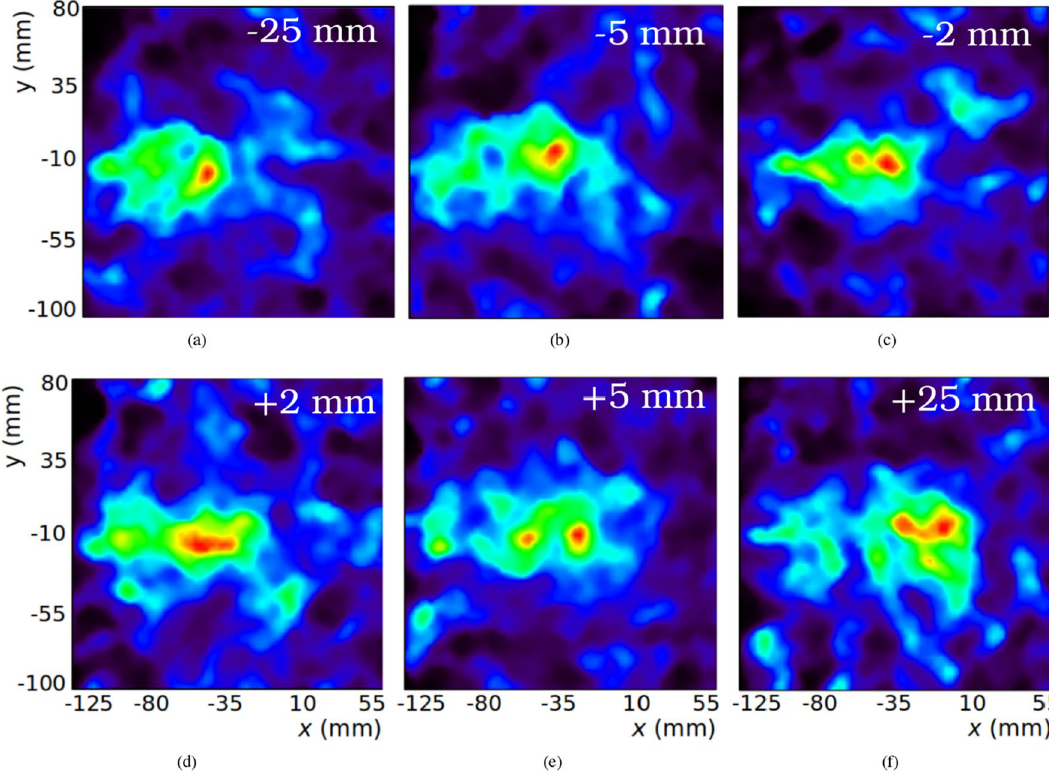
Figure 3. Reconstructed images at 4.4 MeV at 6 different target positions. Top row, from left to right: target at –25 ( a ), –5 ( b ) and –2 mm ( c ). Bottom row, from left to right: target at +2 ( d ), +5 ( e ) and +25 mm ( f